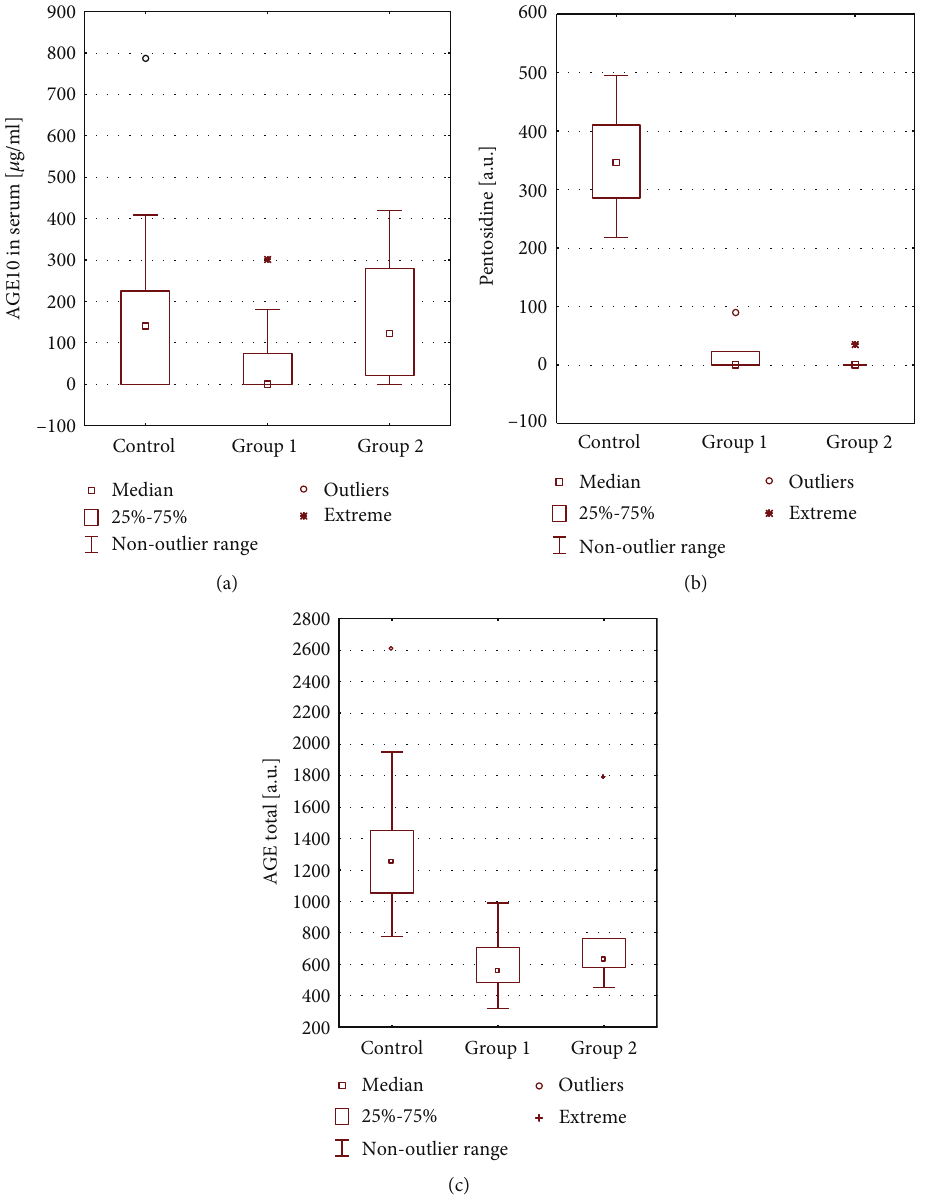
Figure 1: Comparison of AGE level between a group of patients with allergic rhinitis groups and a control group, determined with immunochemical method (a), fl uorescence measurement at 335/385 nm for pentosidine (b), and at 370/440 nm for total fl uorescent AGE (c) of excitation/emission,